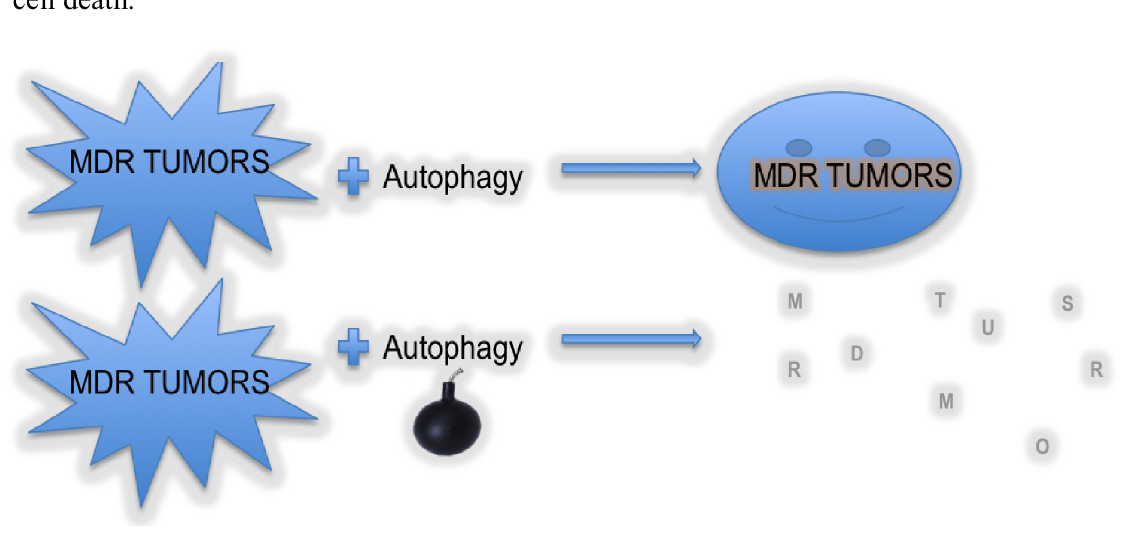
Figure 4. Role of autophagy in MDR tumors. Autophagy has a dual role in MDR tumors. Autophagy may lead to survival of MDR tumors or its activation may lead to tumor cell